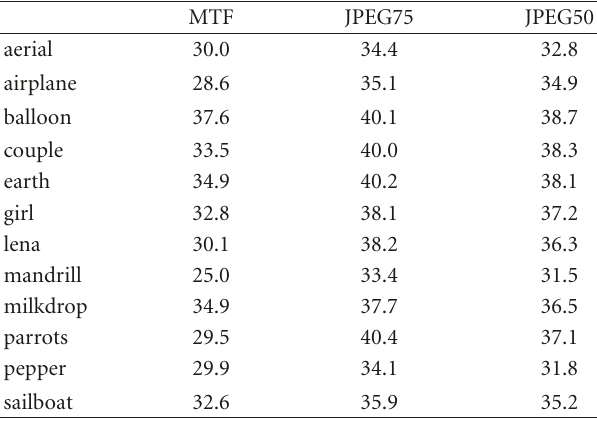
Table 4: PSNRs of watermarked images using the maximum of Q of each